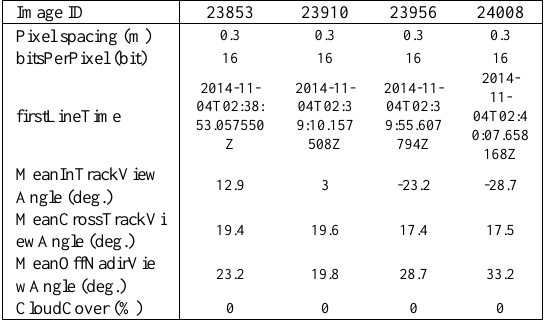
Table 1. Image dataset description